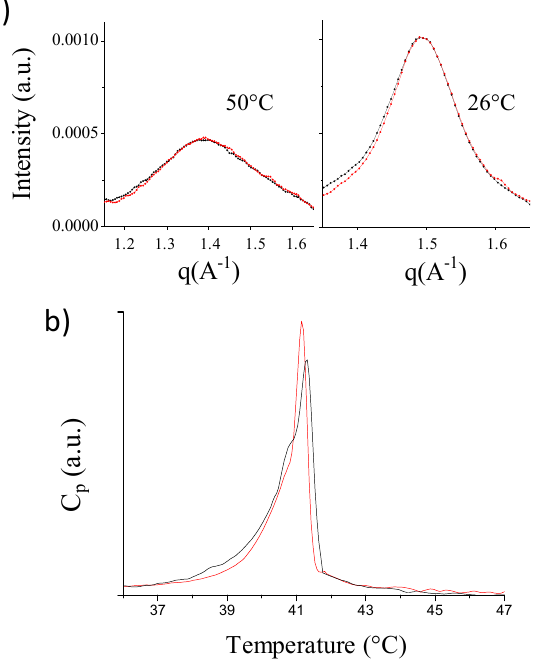
Figure 2. PC-phospholipid bilayers upon interaction with A β mon (wide-angle X-ray scattering (WAXS), differential scanning calorimetry (DSC)). ( a ) Wide Angle X-ray scattering (WAXS) of DPPC vesicles before (black curves) and after 1 h contact at T = 50 °C with A β mon(1–42) (red curves) measured at T = 50 °C (left panel) in the fluid phase of lipid chains and at T = 26 °C (right panel) in the gel phase. ( b ) Differential scanning calorimetry (DSC). Upward T-scan of DPPC vesicles before (black line) and after contact with A β mon(1–42) (red line) showing the downshift of the main peak from 41.3 to 41.15 °C (shoulder from 40.8 to 40.7 °C). c = 20 mg/mL, scan rate 0.25 °C/min.